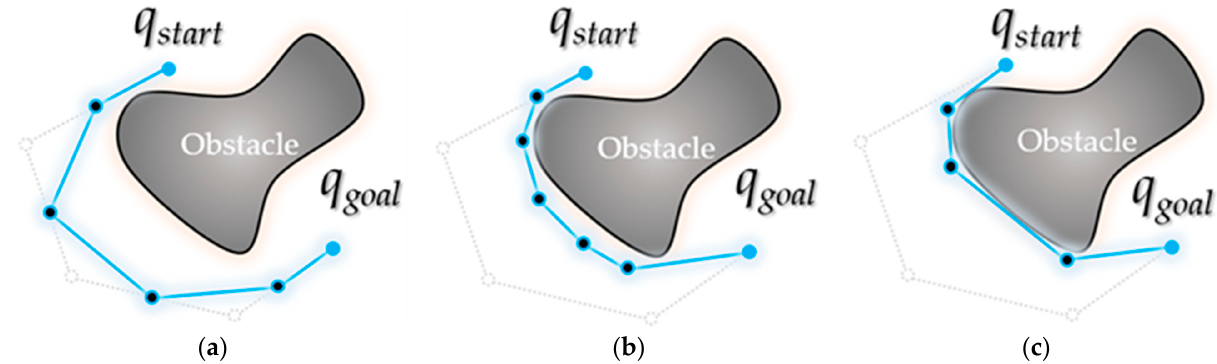
Figure 5. Variations according to ε values in post triangular processing of midpoint interpolation method ( ε value of ( a ) > ε value of ( b ) > ε value of ( c )): ( a ) When ε value is set relatively large; ( b ) When ε value is set relatively medium (smooth path); ( c ) When ε value is set relatively small (closer to the optimal path). Algorithm 3 Pseudocode of Proposed Post Triangular Processing of Midpoint Interpolation Method